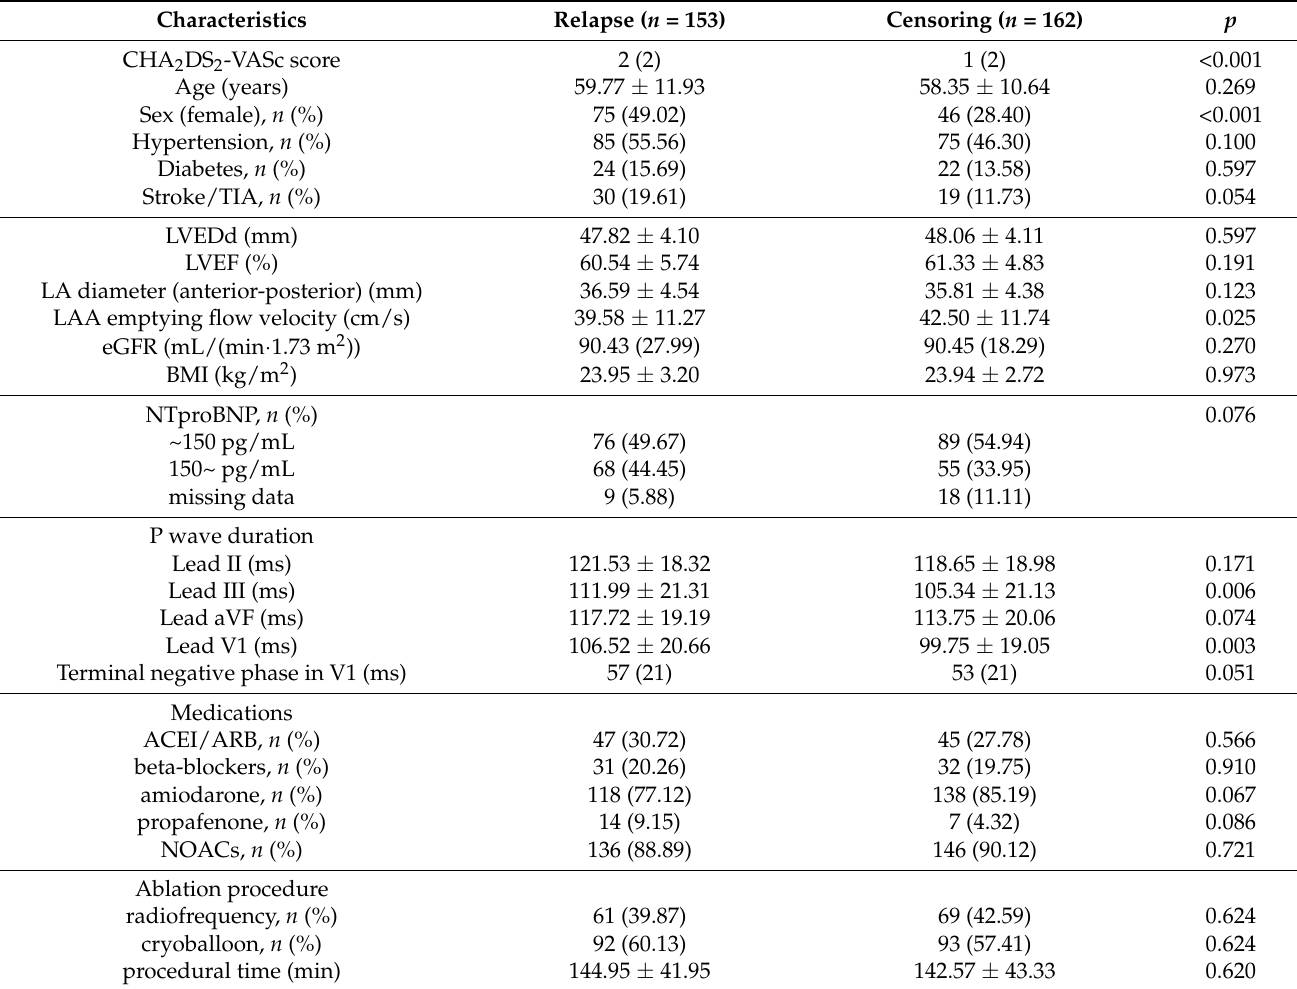
Table 1. Demographic and clinical